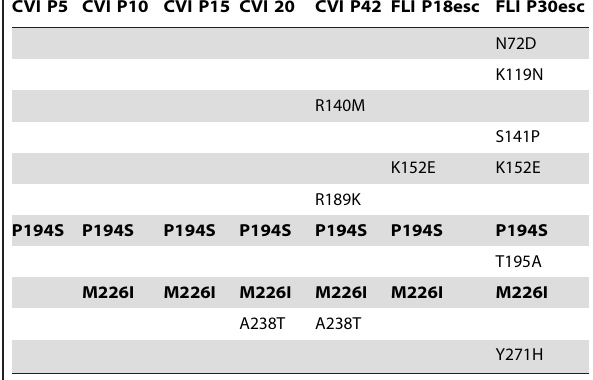
Mutations in bold indicate mutations found by both groups. Numbers refer to the A/goose/Guangdong/1/1996 (Influenza Research Database accession number AF144305) HA amino acid sequence.